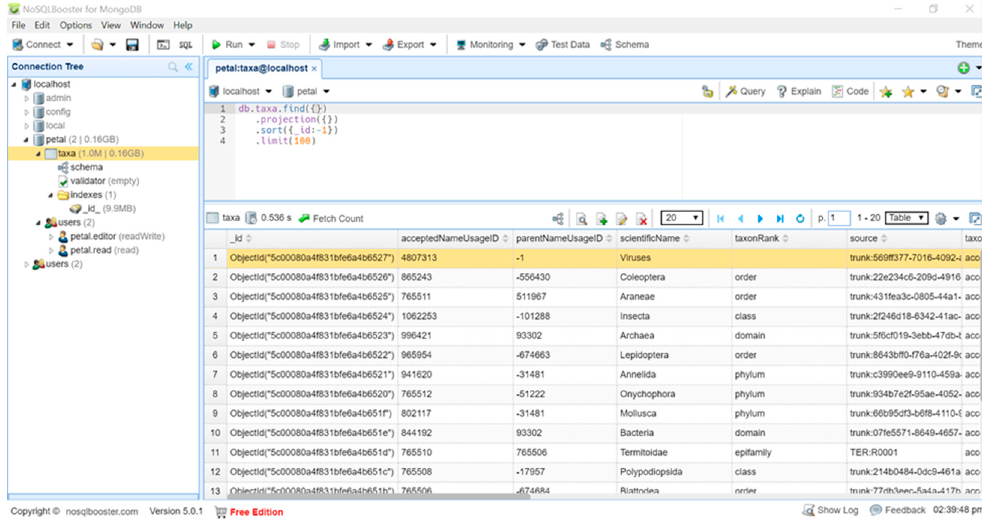
Figure 25. NoSQL Booster showing PeTaL database.